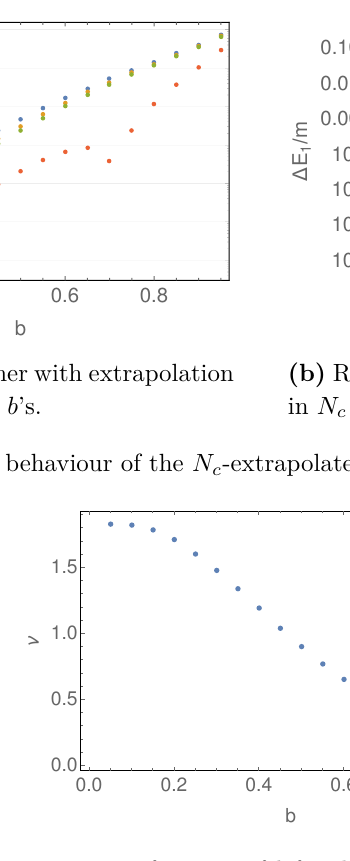
for the raw data obtained at N c